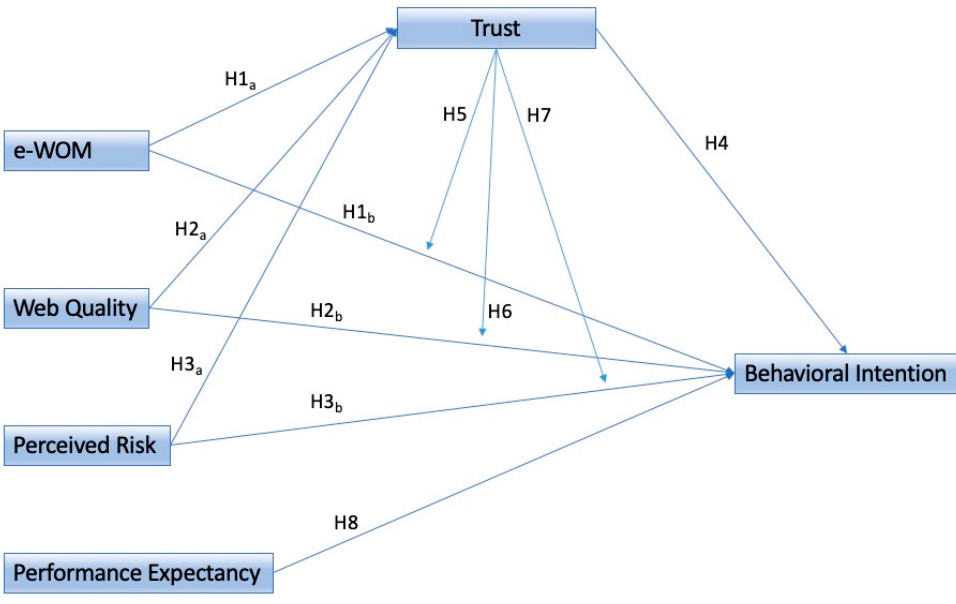
Figure 1. Proposed Figure 1. Proposed model.